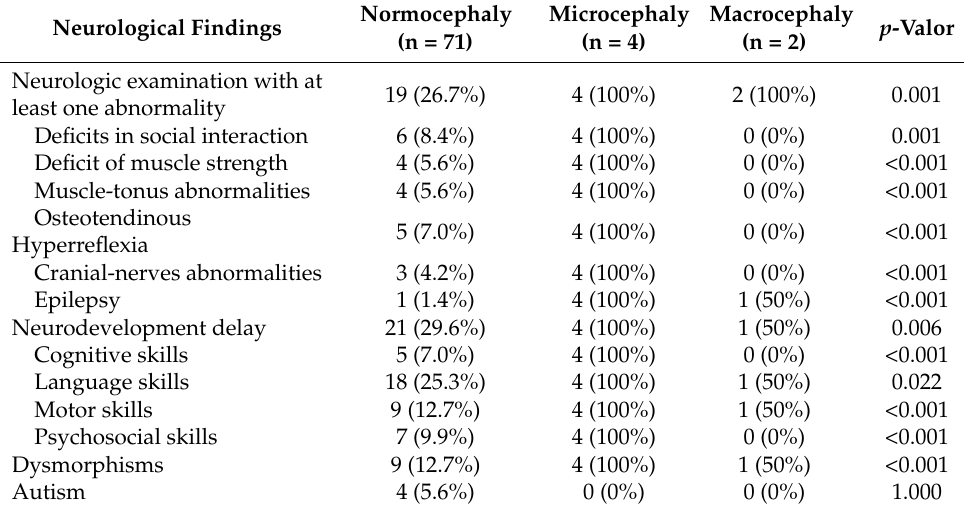
Table 4. Neurological findings related to neuropsychomotor development and physical examination according to head circumference classified at the end of the follow-up period of 77 children exposed to the Zika virus in the intrauterine period, Manaus,